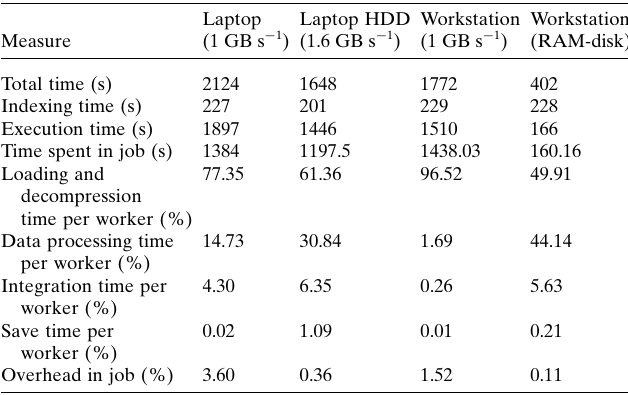
Table 1 Benchmarking timings of the algorithm for different real-world